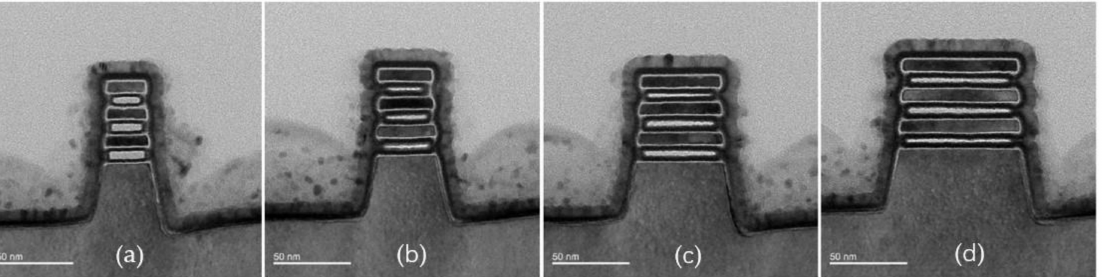
Figure 6. TEM cross-sectional images of stacked nanosheets with multiple widths obtained by multi-step etching with the application of oxidation treatment. ( a ) 30 nm; ( b ) 40 nm; ( c ) 60 nm; ( d ) 80